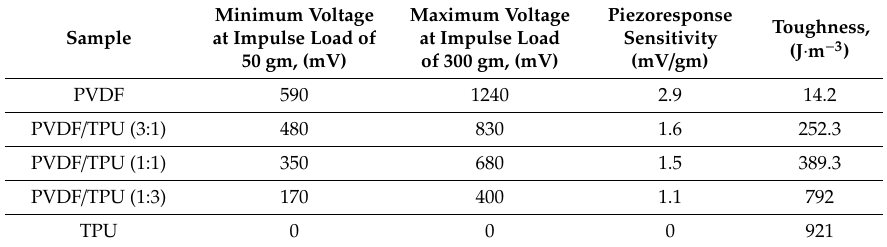
Table 3. Piezoelectric properties of nanofibrous composites membranes compared to mechanical properties.